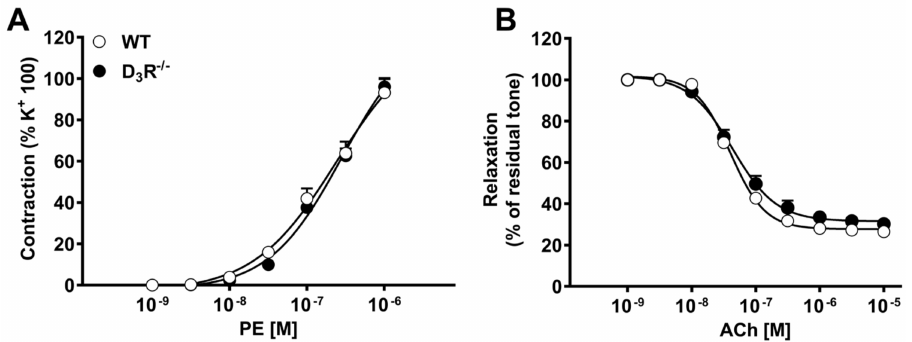
Figure 1. Vasomotor responses in aortic segments isolated from wild-type (WT) and D3R − / − mice. ( A ) Vasoconstriction induced by cumulative concentrations of phenylephrine (PE); ( B ) vasodilatation to cumulative concentrations of acetylcholine (ACh). Each curve (with vertical bars representing standard errors) represents the average from 10–12 preparations.